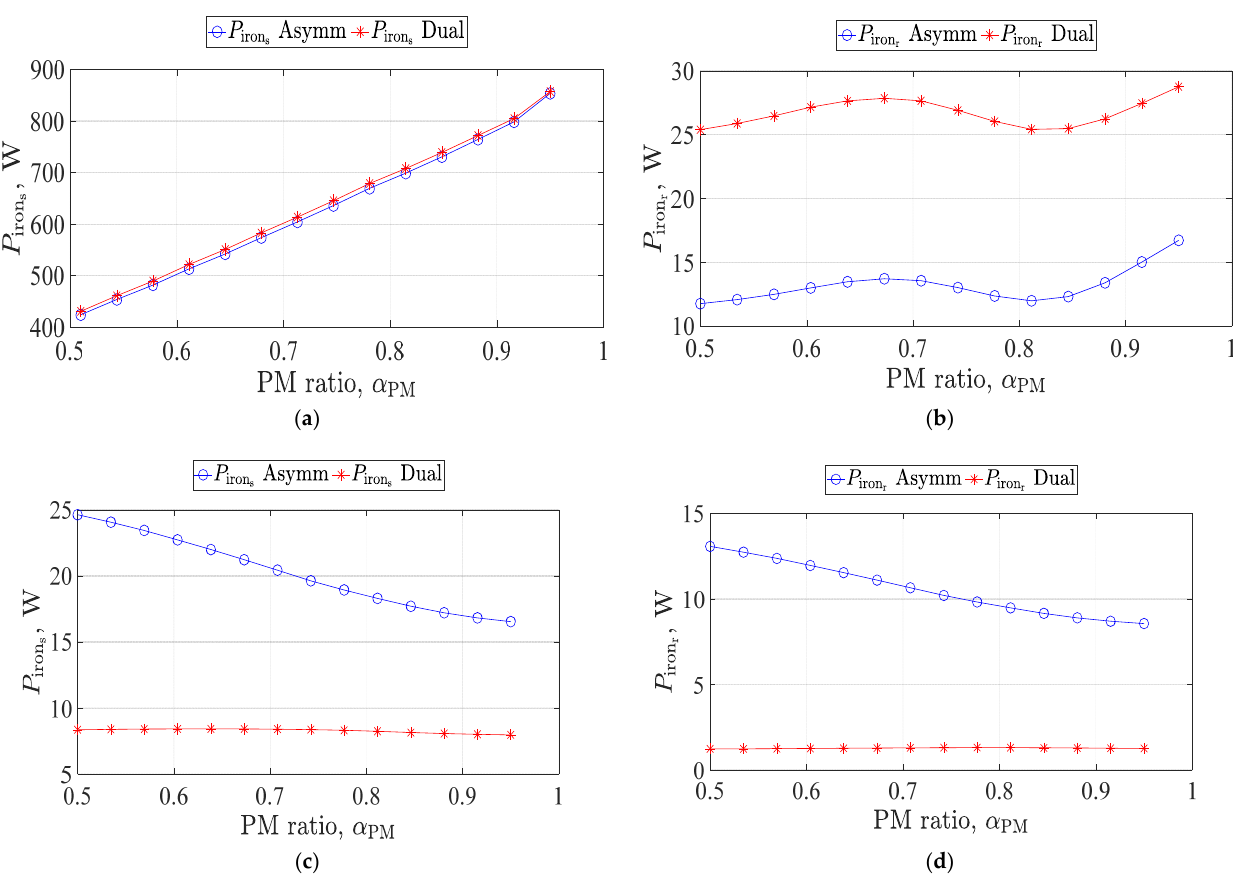
Figure 10. Variation in stator and rotor core losses with PM width-to-pole pitch ratio under various operational modes. ( a ) Stator iron losses under propulsion. ( b ) Rotor iron losses under propulsion. ( c ) Stator iron losses under charging. ( d ) Rotor iron losses under charging.